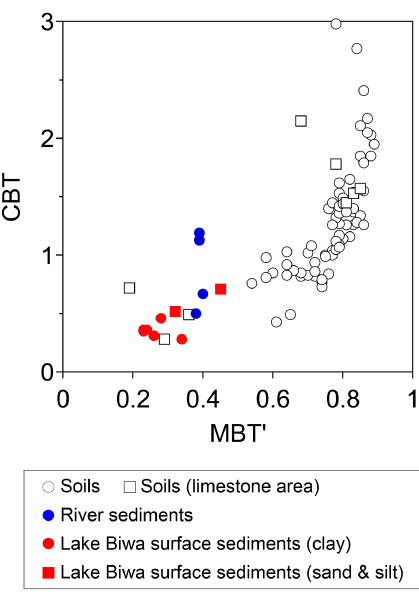
Figure 4. Plot of CBT against MBT 0 for soils, river sediments, and Lake Biwa surface sediments (Ajioka et al., 2014).